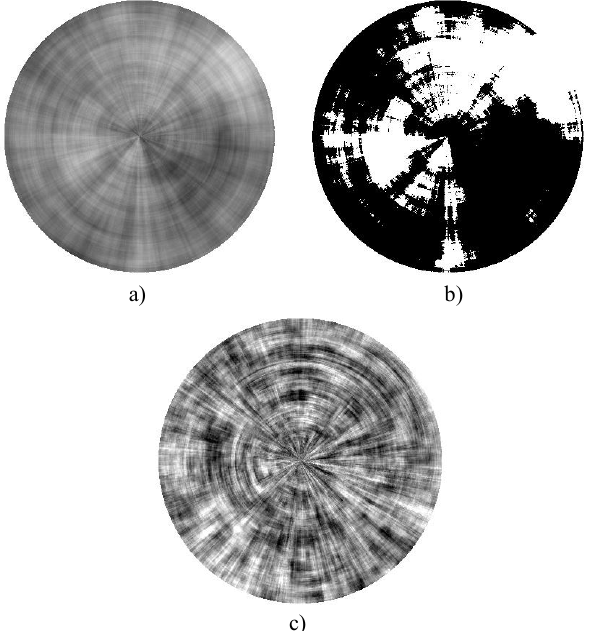
Figure 12. Simulation of inhomogeneous images: a) the control image, b) its threshold section, c) the resulting image